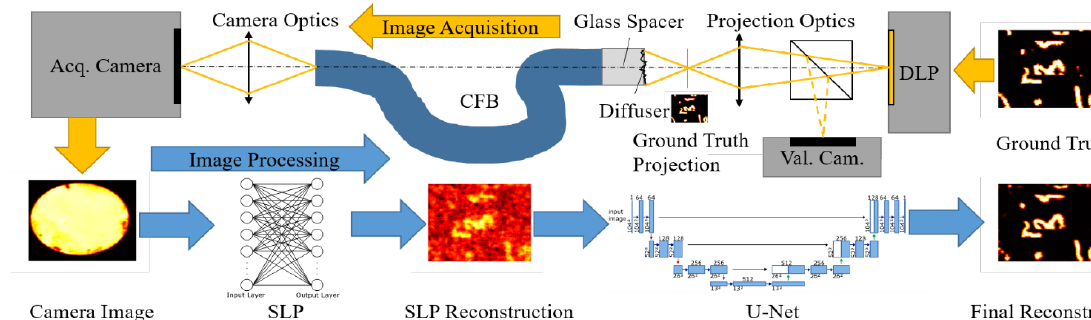
Fig. 1. Sketch of training setup, diffuser endoscope and image